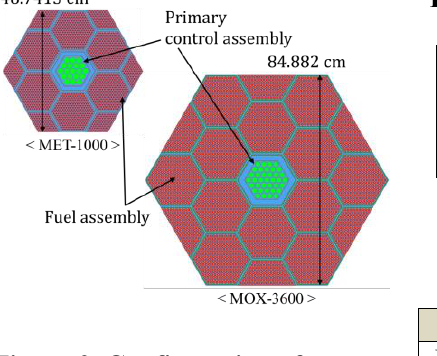
Figure 9. Configuration of super- cell models